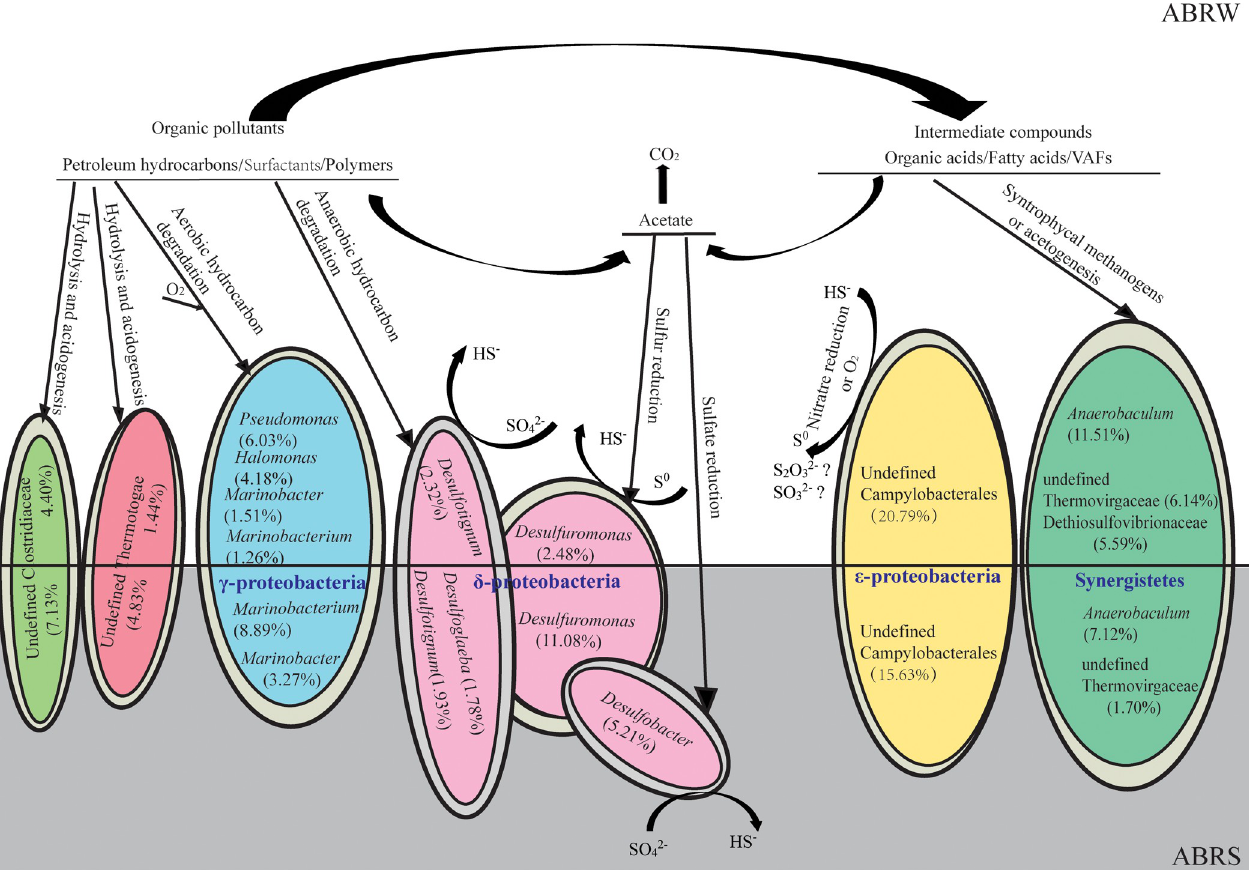
Fig 4. Schematic diagram of the ecosystem involving dominant microbial distributions and potential organics conversion processes in the water phase (ABRW) and sludge phase (ABRS) of the anaerobic baffled reactor.